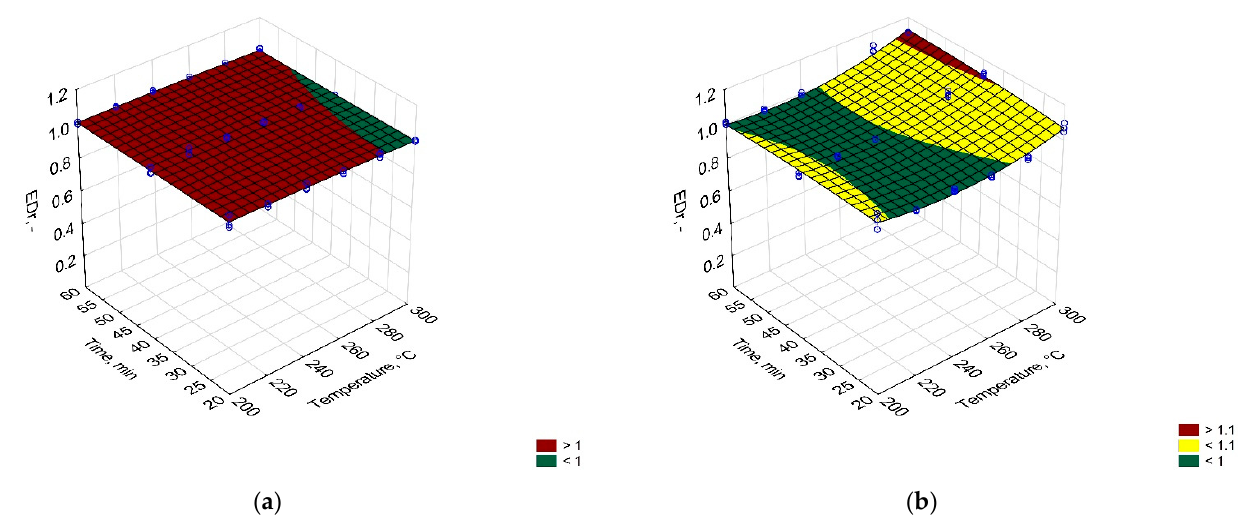
Figure 3. Temperature and time effect on the energy densification ratio (EDr) of carbonized solid fuel made from ( a ) PLA and ( b ) PAP.